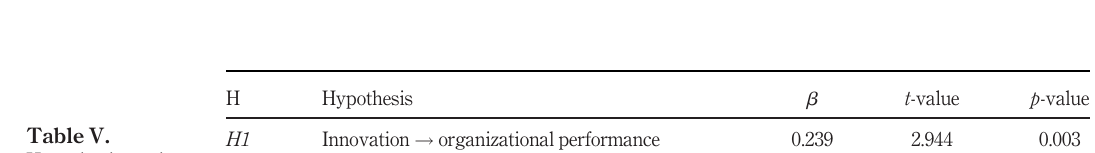
Table V. Hypothesis testing